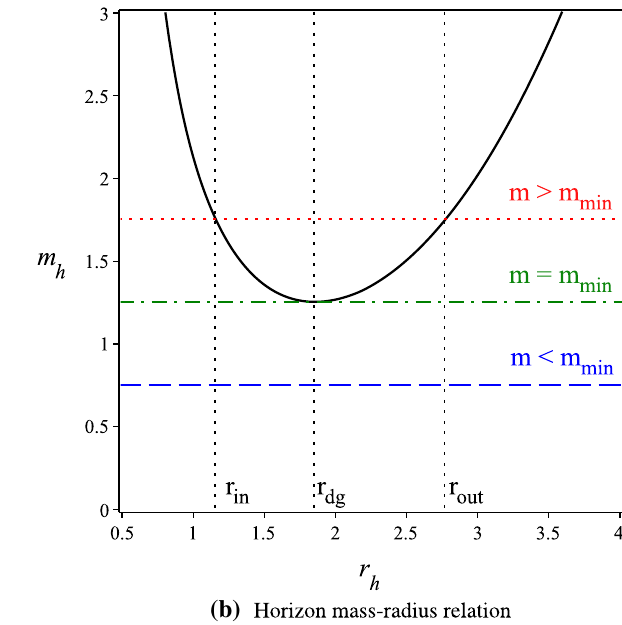
degenerate horizon (92), where m > m min the BH has two horizons ( r in and r out ) at most, while for m < m min case the BH is naked. We take β = 1 / 4 and q = p =